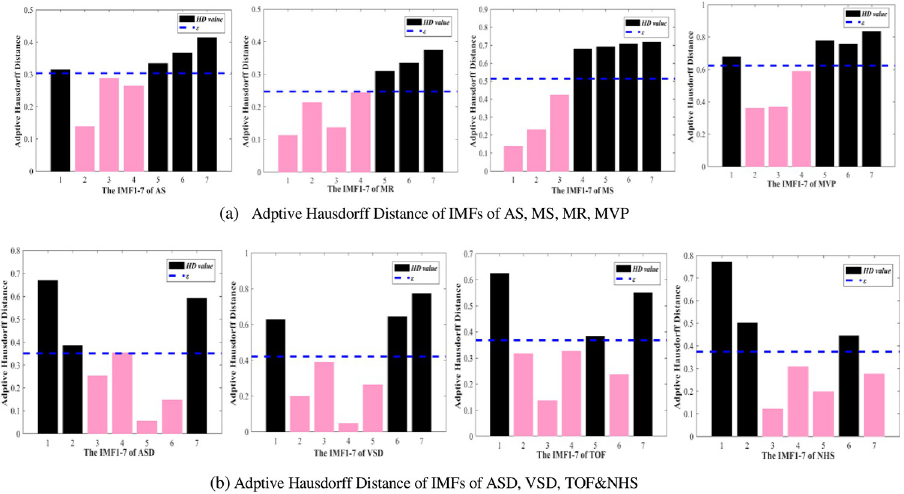
Fig 7. Adaptive selection based on the mean of the first 7 layers of HD. (a) Adptive Hausdorff Distance of IMFs of AS, MS, MR, MVP; (b) Adptive Hausdorff Distance of IMFs of ASD, VSD, TOF&NHS.